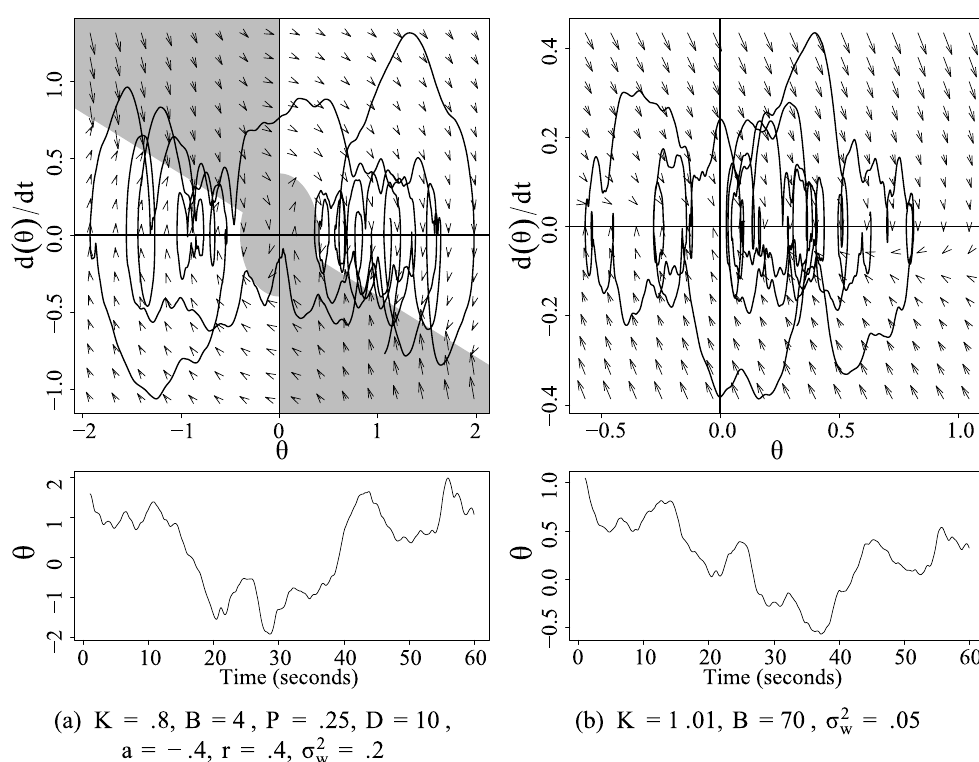
Fig 11. Phase portraits and time series from two models generated from the same vector of noise (scaled by σ w ). In (a) data were simulated from the ISDDE model with the theoretical priors. In (b) data were simulated from a 3-parameter SDE. The large ratio of derivative (B) to proportional (K) force results in non-equilibrium Langevin dynamics that may exhibit similar features to the ISDDE for limited periods of time. Characteristic features distinguish (a) from (b), such as sharp changes in velocity localized to quadrants II and IV, slow change in velocity associated with quadrants I and III, and higher density at two spatial equilibria.